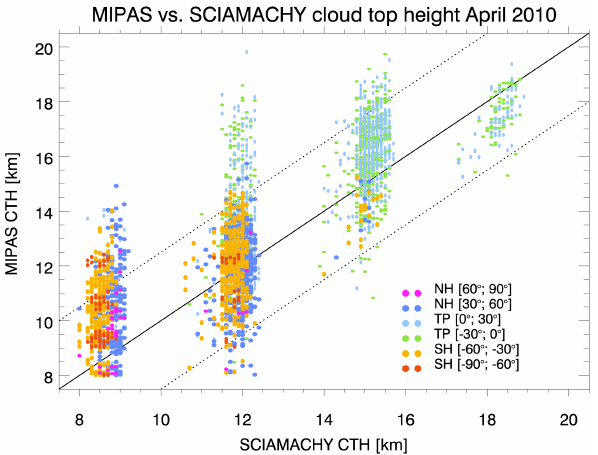
Figure 15. Zonal monthly means of co-located cloud top height dif- ferences (in %) between MIPAS and SCIAMACHY (black line with diamonds) and the corresponding 1 σ standard deviation (dashed black line) for the time period between 2008 and the end of mis- sion in April 2012. The differences for four SCIAMACHY tangent heights (TH) between 8.5 and 18.5km are also shown as coloured